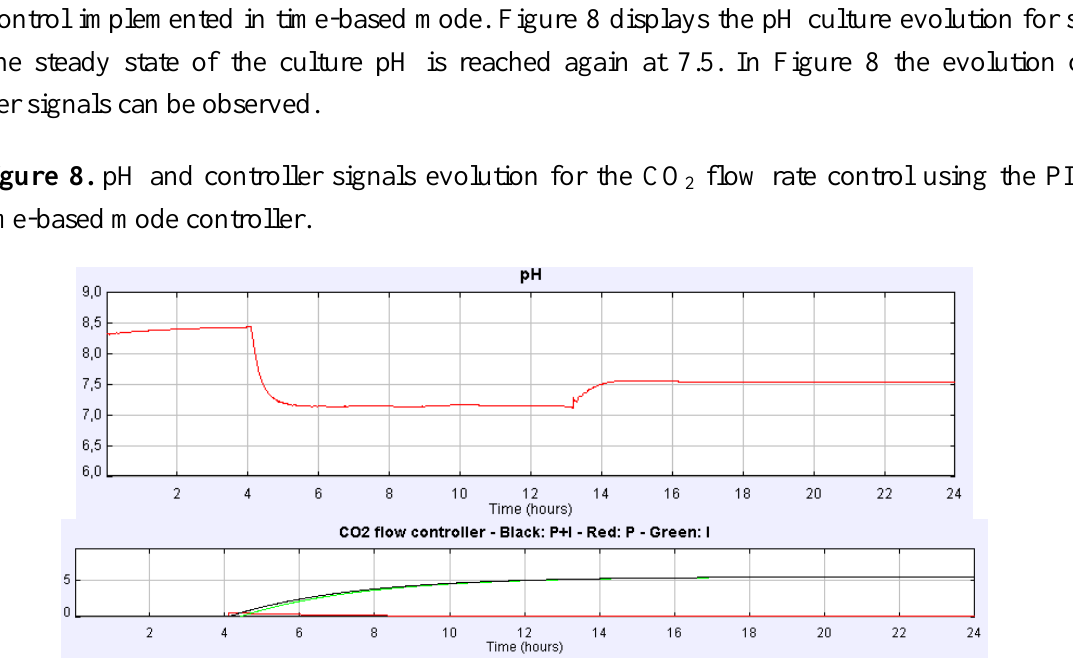
flow rate control using the PI 2